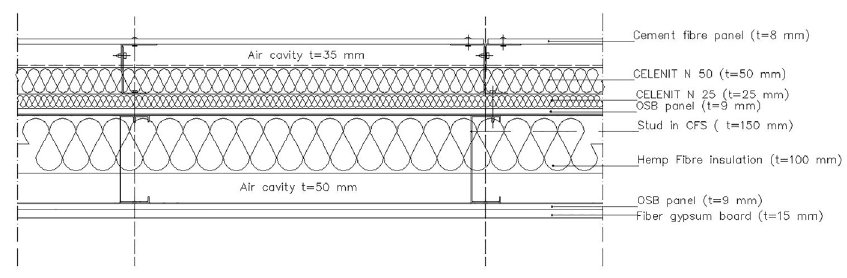
Figure 3. External wall section of the British Foundation school.